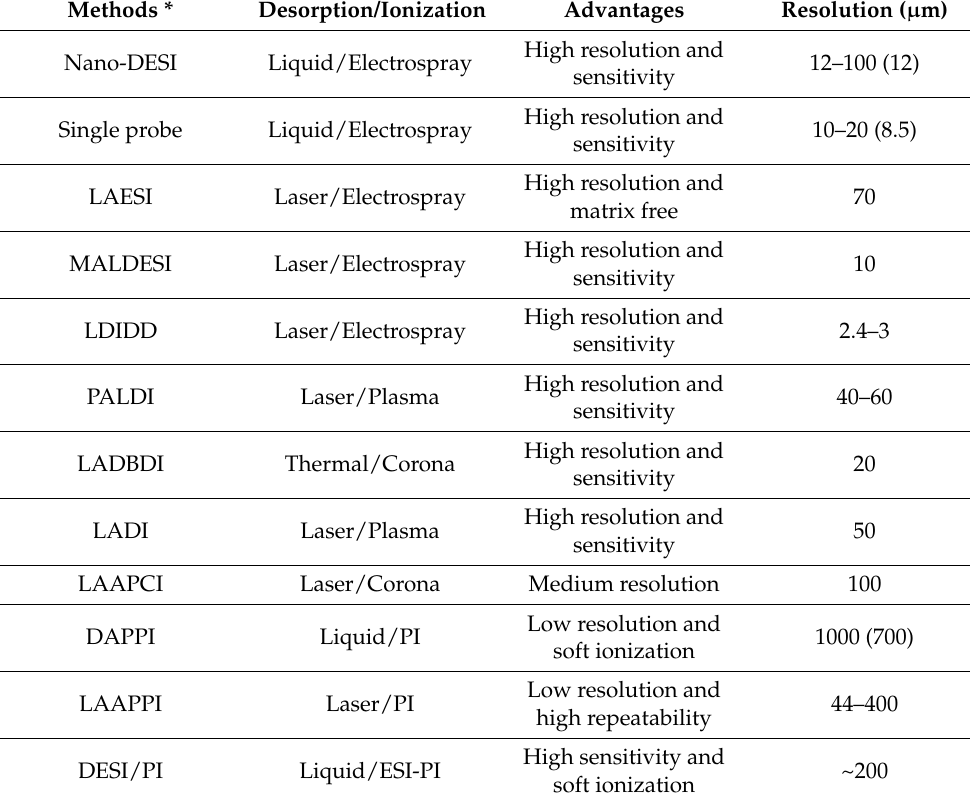
Table 2. Summary of two-step desorption/ionization for